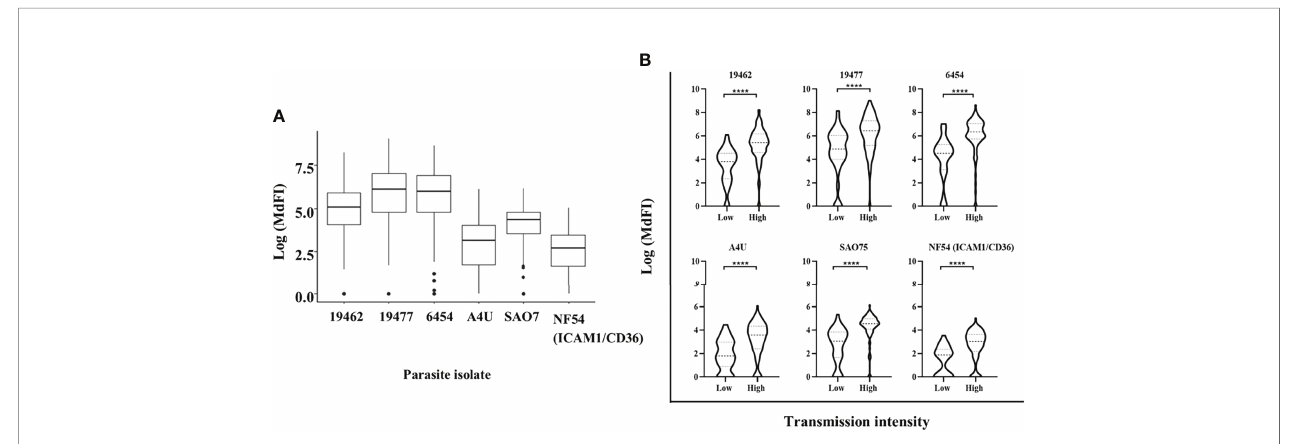
FIGURE 1 | Anti-VSA antibodies response and malaria endemicity. (A) The median and interquartile range of anti-VSA antibodies levels (expressed as log median fl uorescent intensity) against the panel of isolates. (B) Comparison of anti-VSA IgGs (expressed as log median fl uorescent intensity) among individuals from low and high malaria transmission areas. (**** - P-value =